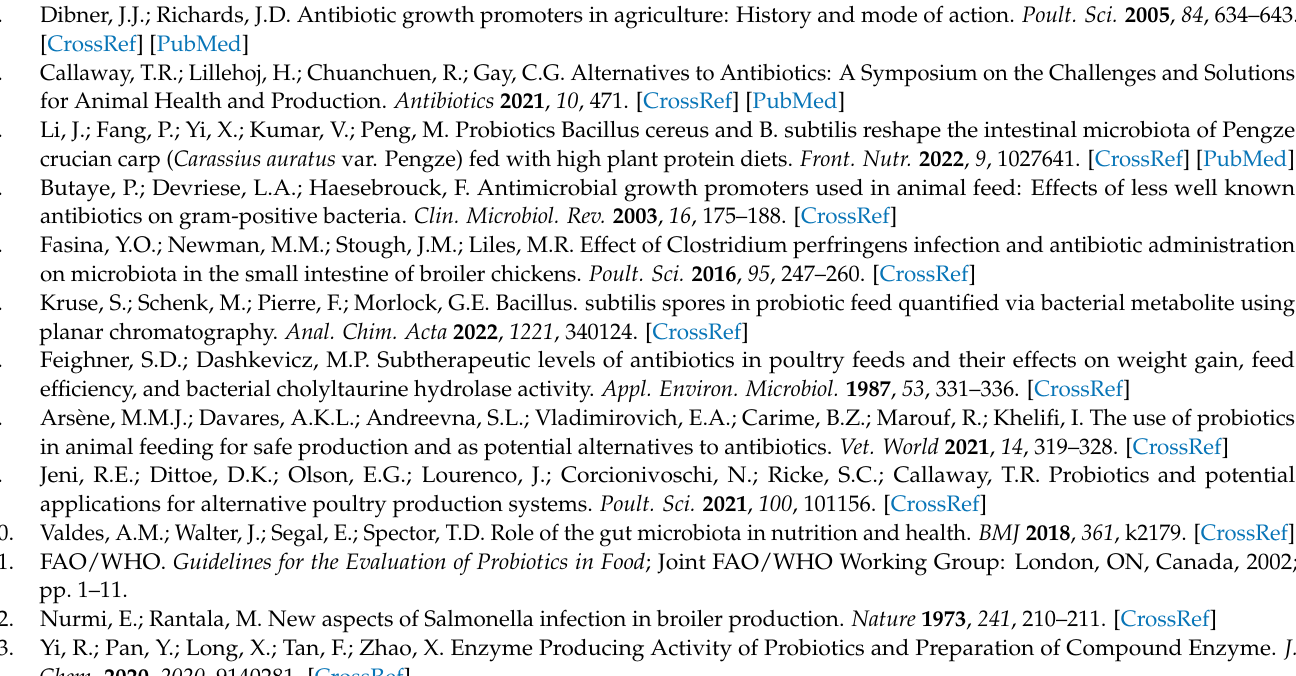
Figure S21: (+)-LRESIMS spectrum of compound 5; Figure S22: 1 H NMR (800 MHz, DMSO) spectrum of compound 5; Figure S23: 1 H – 1 H COSY spectrum of compound 5 in DMSO; Figure S24: HSQC spectrum of compound 5 in DMSO; Figure S25: HMBC spectrum of compound 5 in DMSO; Table S6: Experimental NMR data of compound 6 in DMSO- d 6 at 25 ◦ C; Figure S26: (+)-LRESIMS spectrum of compound 6; Figure S27: 1 H NMR (800 MHz, DMSO) spectrum of compound 6; Figure S28: 1 H – 1 H COSY spectrum of compound 6 in DMSO; Figure S29: HSQC spectrum of compound 6 in DMSO; Figure S30: HMBC spectrum of compound 6 in DMSO; Table S7: Experimental NMR data of compound 7 in DMSO- d 6 at 25 ◦ C; Figure S31: (+)-LRESIMS spectrum of compound 7; Figure S32: 1 H NMR (800 MHz, DMSO) spectrum of compound 7; Figure S33: 1 H – 1 H COSY spectrum of compound 7 in DMSO; Figure S34: HSQC spectrum of compound 7 in DMSO; Figure S35: HMBC spectrum of compound 7 in DMSO; Table S8: Experimental NMR data of compound 8 in DMSO- d 6 at 25 ◦ C; Figure S36: (+)-LRESIMS spectrum of compound 8; Figure S37: 1 H NMR (800 MHz, DMSO) spectrum of compound 8; Figure S38: 1 H – 1 H COSY spectrum of compound 8 in DMSO; Figure S39: HSQC spectrum of compound 8 in DMSO; Figure S40: HMBC spectrum of compound 8 in DMSO; Figure S41: LC-MS chromatograms of caecum extracts produced from a single animal sample fed with Bacillus composition F1; Table S9: Antimicrobial activity of EtoAc and crude extracts of Bacillus strains (green tick: active; red cross: inactive); Figure S42: Stacked 1 H NMR spectra of Bacillus EtoAC